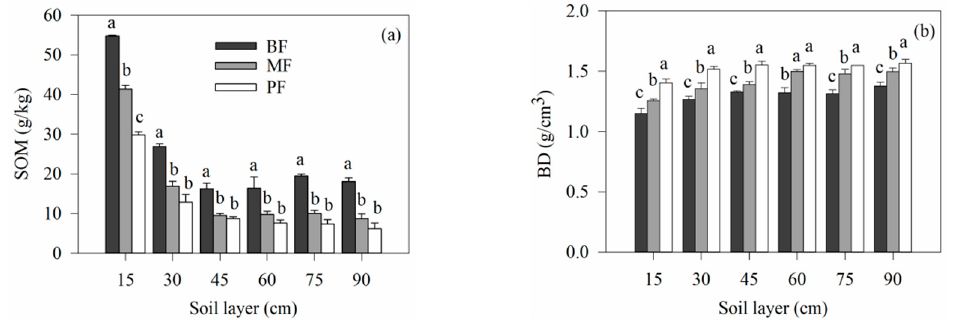
Figure 2. Soil organic matter ( a ) and bulk density ( b ) of the 0–90 cm soil layer of di ff erent forests. Values are the means ± SE. Lowercase letters above the columns represent statistically significant di ff erences among stand types for the same soil layer (Duncan’s test, p < 0.05). Abbreviations: SOM, soil organic matter; BD, bulk density; PF, Pinus massoniana forest; MF, mixed Pinus massoniana / broad-leaved forest; BF, monsoon evergreen broad-leaved